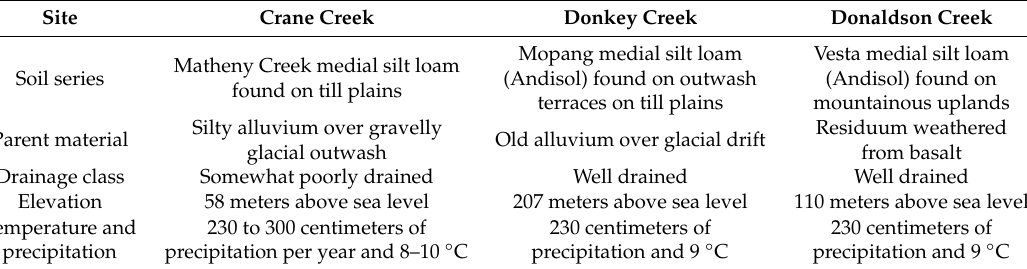
Table 1. Soil, elevation, and climatic characteristics of the selected sites